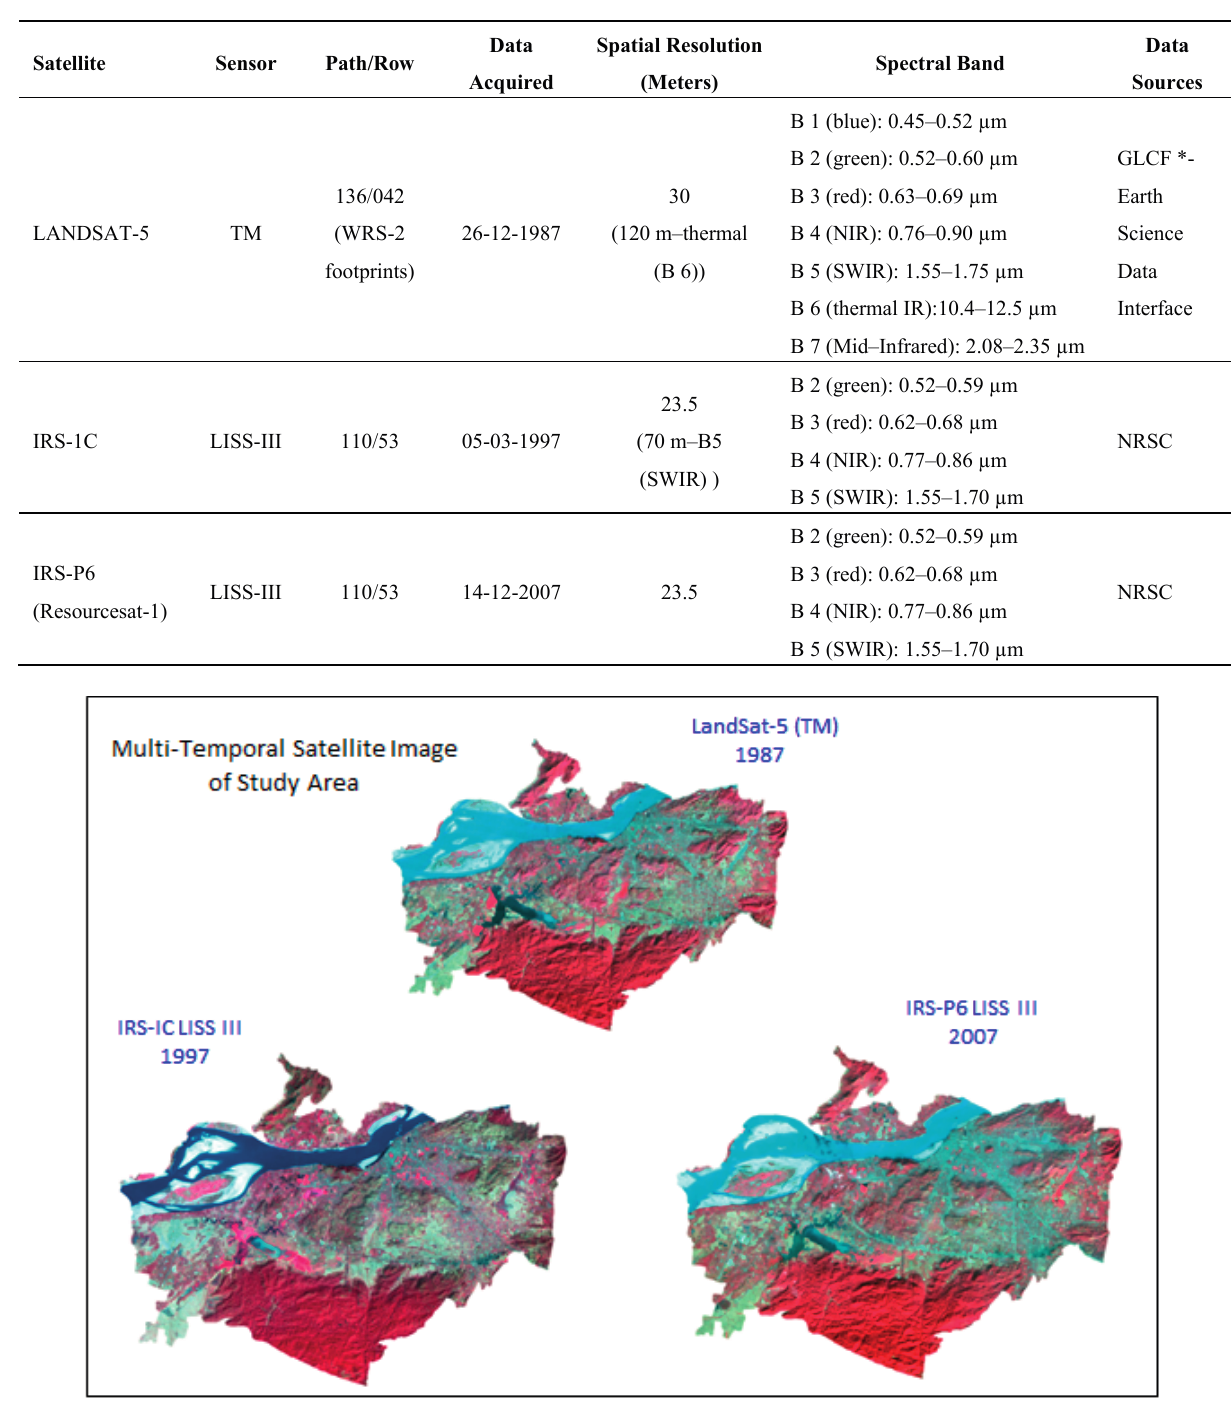
Figure 2. Satellite images of study area